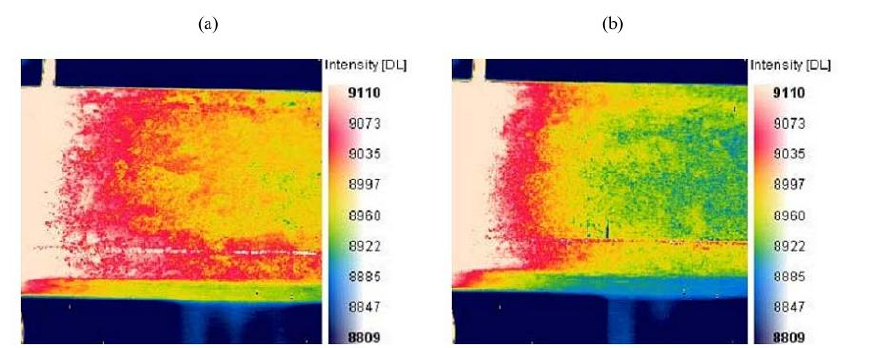
Experimental results of a real test object with the cross-sectional area of 50 × 50 mm ( a ) without water and ( b ) with water (Reproduced from [16] with